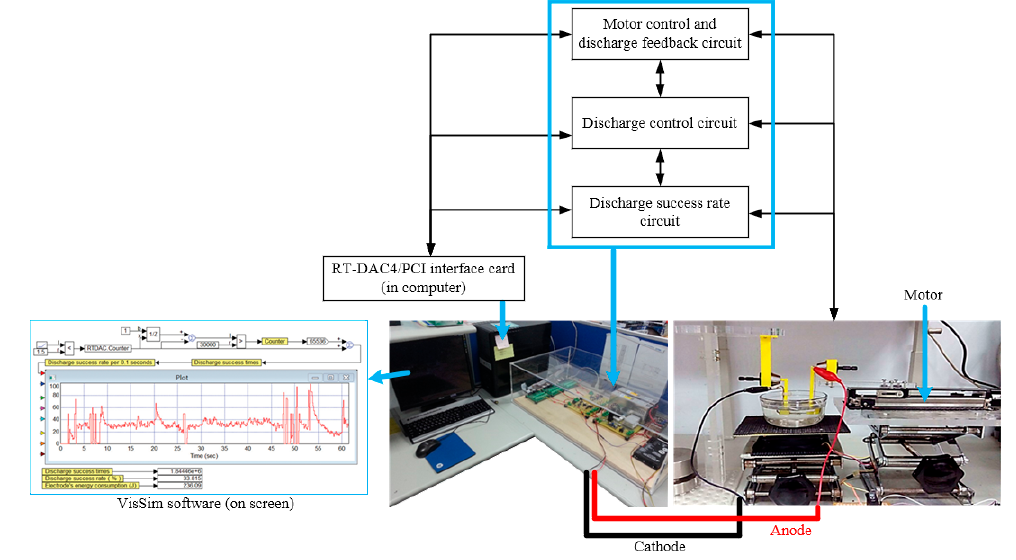
Figure 3. Picture of micro-EDM.